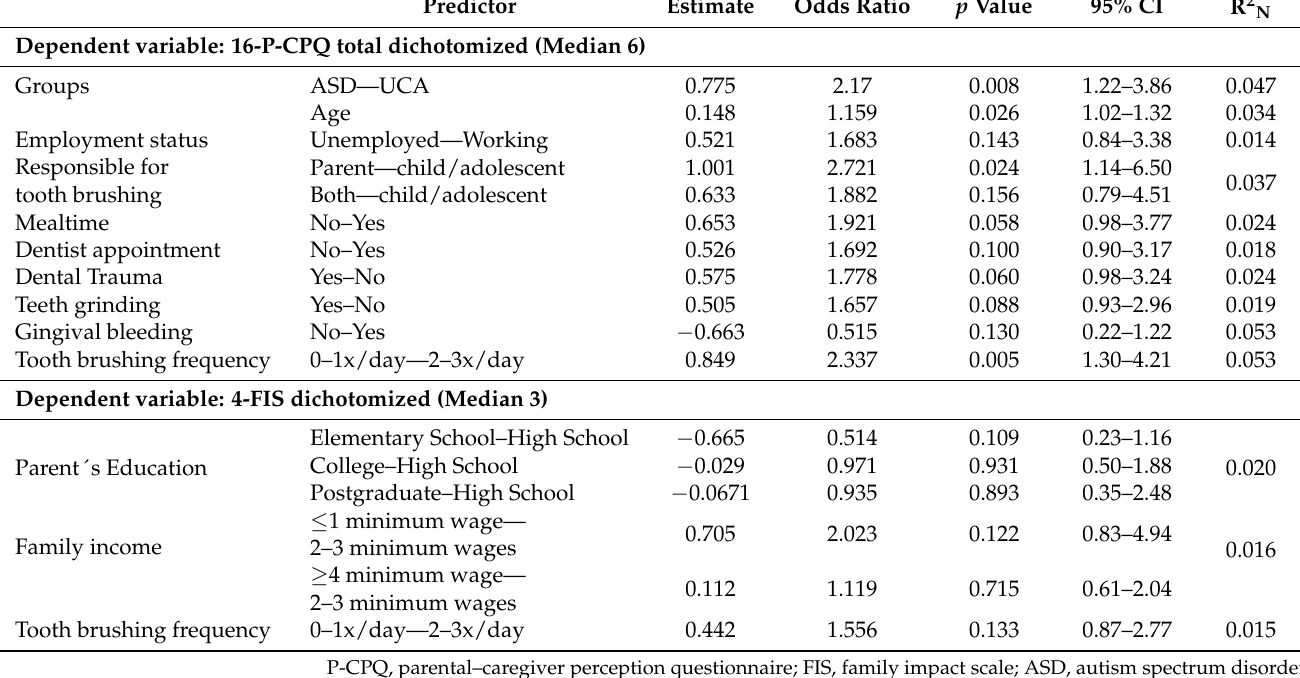
Table 6. Univariate logistic regression. The independent variables only with p values equal to or less than